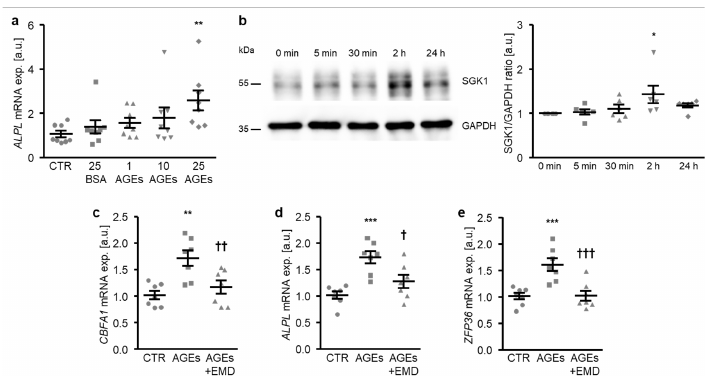
Figure 6. SGK1 inhibition suppresses AGEs-induced osteogenic signaling in HAoSMCs. ( a ) Scatter dot plots and arithmetic means ± SEM ( n = 8; arbitrary units, a.u.) of the ALPL relative mRNA expression in HAoSMCs following treatment with control (CTR), 25 µ g / mL of control BSA (BSA), or the indicated concentrations of AGE-BSA (AGEs; 1–25 µ g / mL). ( b ) Representative original Western blots and scatter dot plots and arithmetic means ± SEM ( n = 6; a.u.) of the normalized SGK1 / GAPDH protein ratio in HAoSMCs following treatment for the indicated time (0–24 h) with 25 µ g / mL of AGE-BSA. ( c – e ) Scatter dot plots and arithmetic means ± SEM ( n = 7; a.u.) of the CBFA1 ( c ), ALPL ( d ), and ZFP36 ( e ) relative mRNA expression in HAoSMCs following treatment with control (CTR) or 25 µ g / mL of AGE-BSA (AGEs) without or with 50 µ M of SGK1 inhibitor EMD638683 (EMD). * p < 0.05, ** p < 0.01, *** p < 0.001 significant vs. control HAoSMCs; † p < 0.05, †† p < 0.01, ††† p < 0.001 significant vs. AGEs-treated